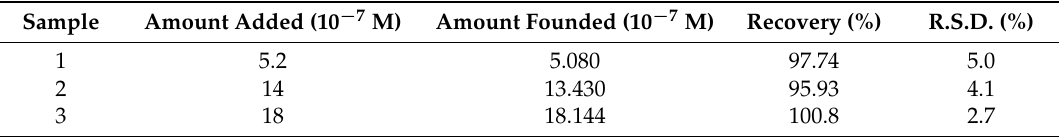
Table 3. The application of the proposed method for melamine detection in milk samples spiked with different concentrations of melamine ( n = 3, average value of three